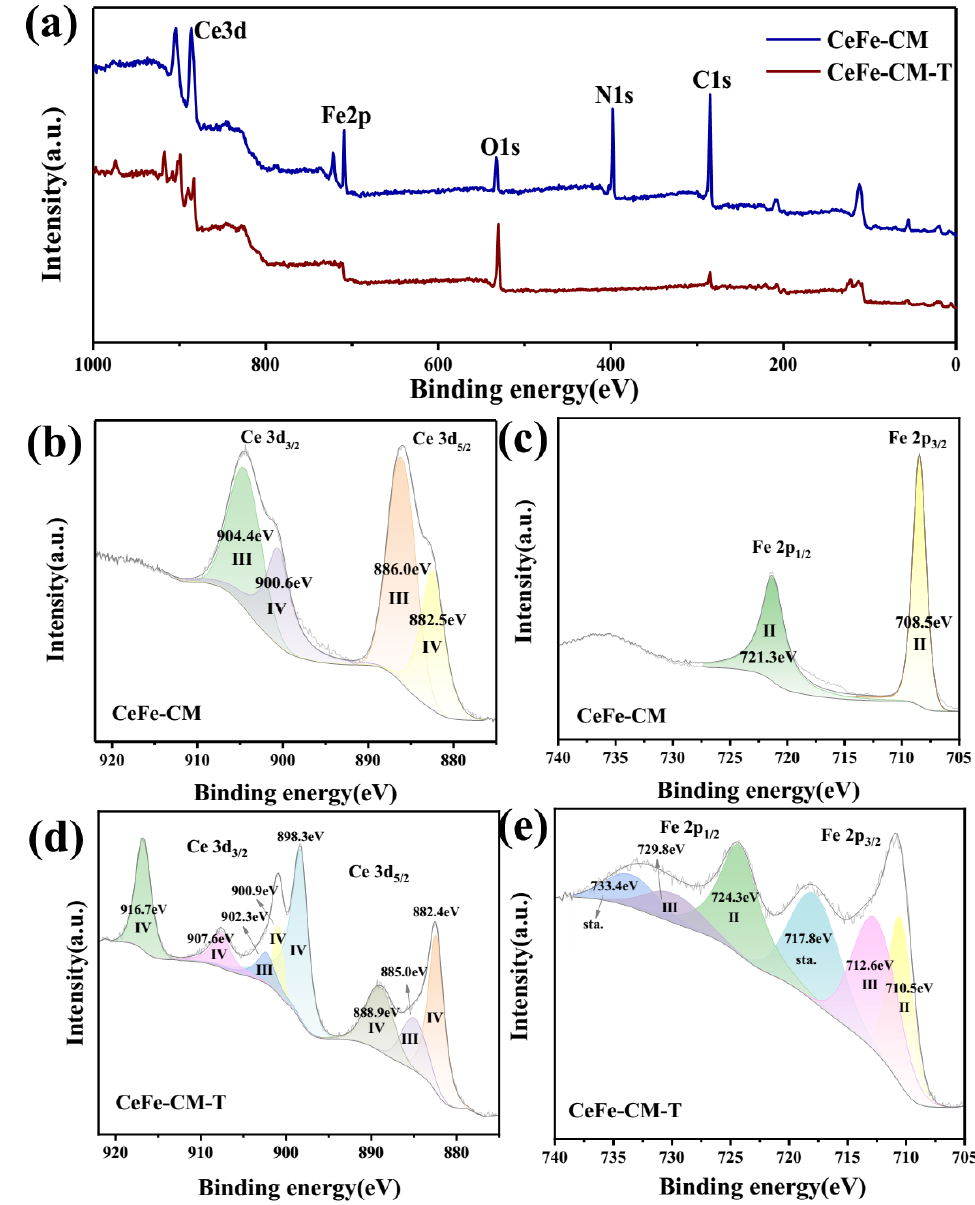
Figure 3. ( a ) XPS spectra of CeFe-CM and CeFe-CM-T; high-resolution XPS spectra of Ce 3d and Fe 2p of CeFe-CM ( b , c ) and CeFe-CM-T ( d,e ).